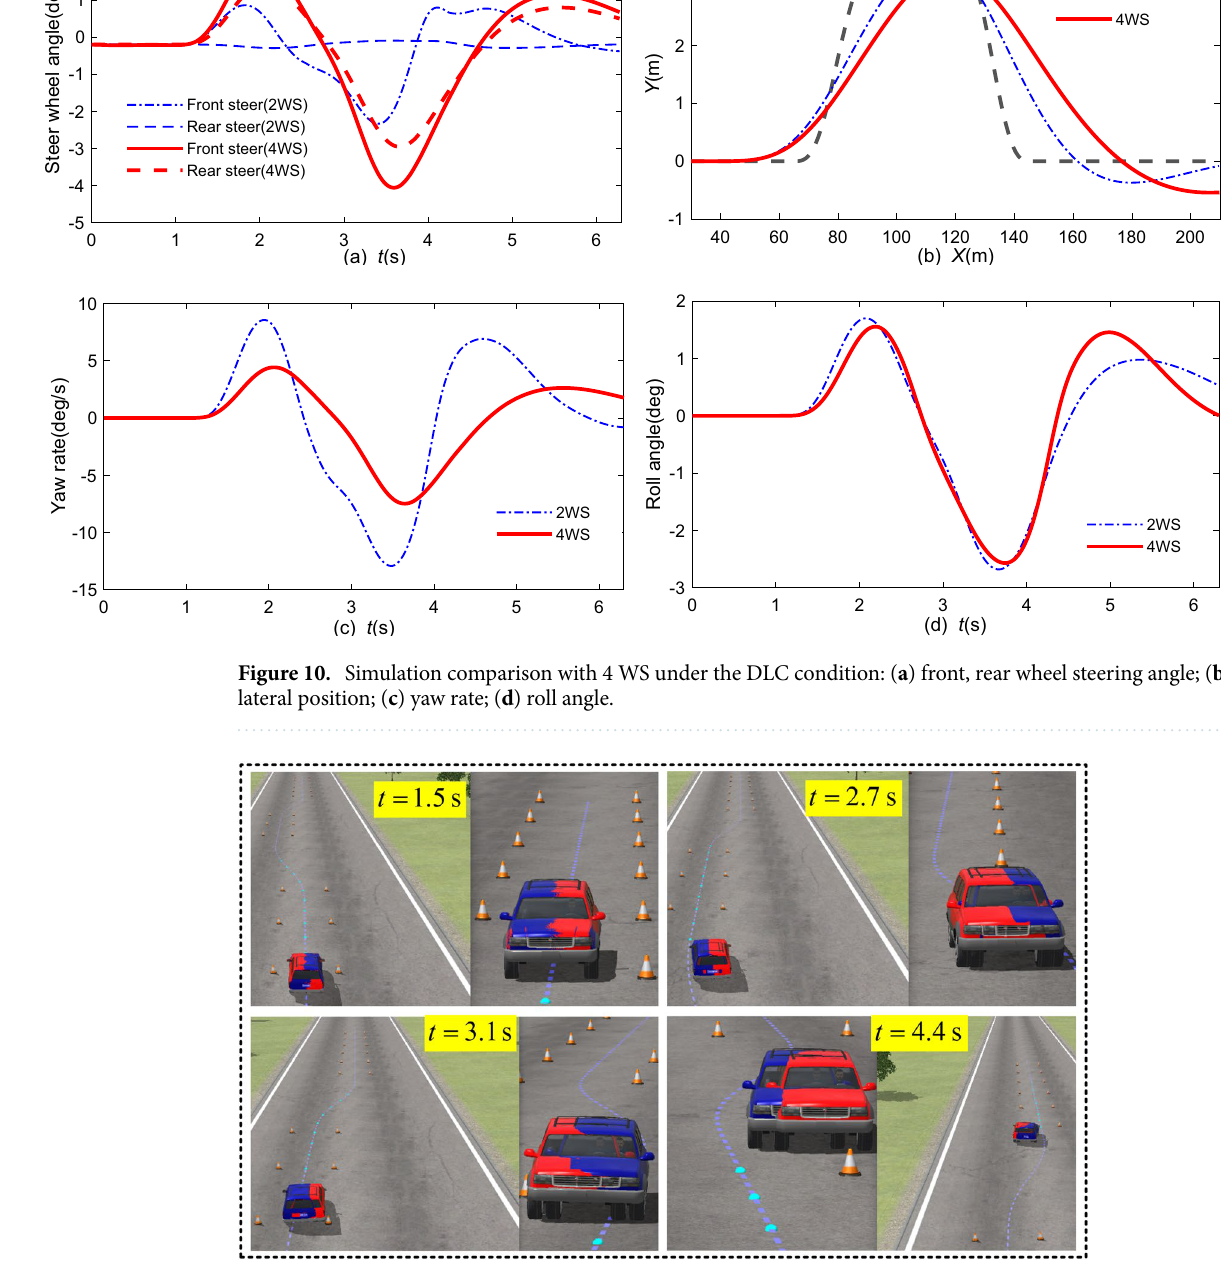
Figure 11. Dynamic visualization of collision avoidance (the blue and red cars are related to 2 WS and 4 WS,